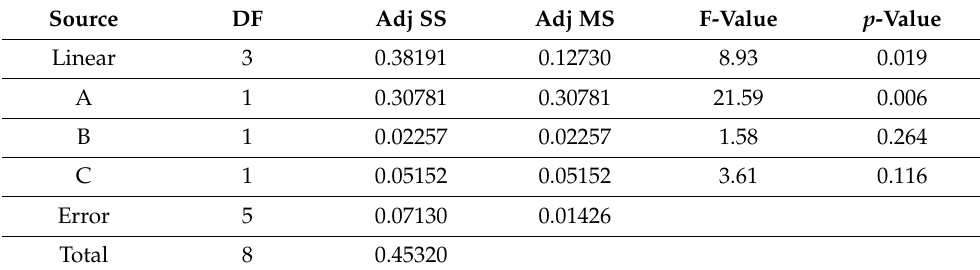
Table 5. ANOVA results for the roughness signal-to-noise ratio. (R 2 =